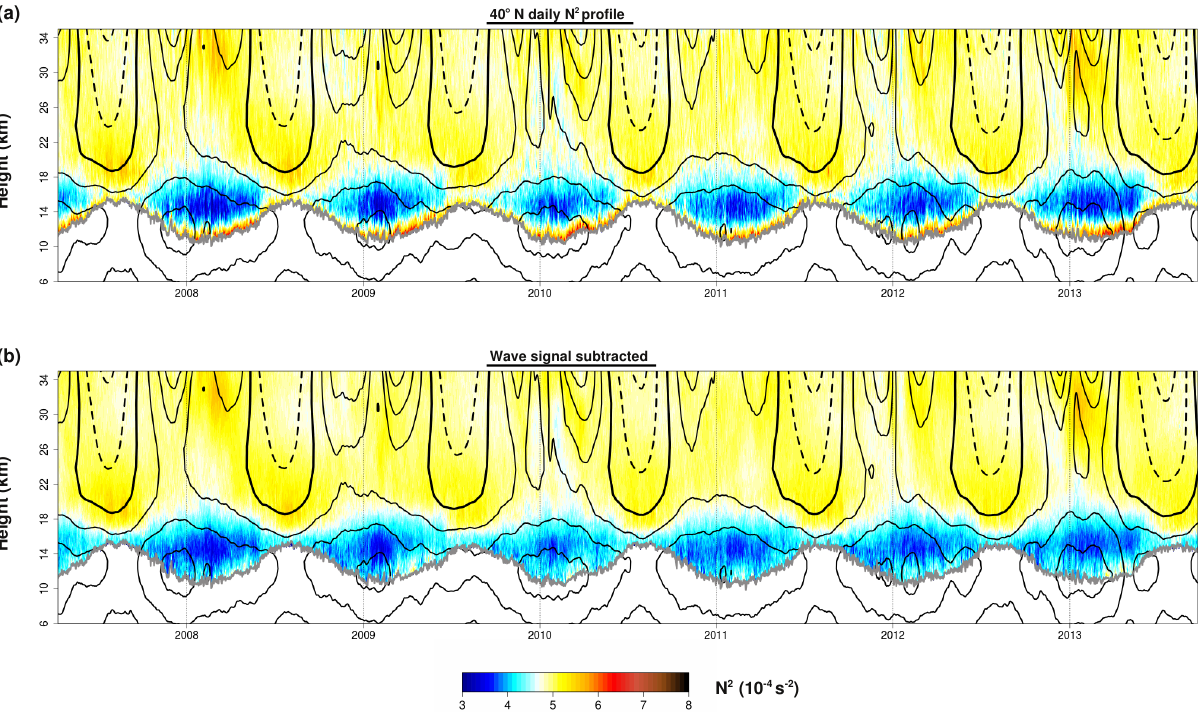
Figure 5. (a) Daily evolution of the tropopause-based, 40 ◦ N zonal mean N 2 vertical profile between 2007 and 2013 (colors) from COSMIC GPS-RO profiles. The grey line denotes the tropopause height (TP z ). Thin black contours denote positive (westerly) mean zonal wind, with a thicker contour for the zero line, dashed contours for negative (easterly) winds, and a 10ms − 1 separation. Winds were obtained from the ERA-Interim reanalysis. To improve visibility, the winds are displayed with a running mean of ± 15 days. No running mean is applied to the N 2 vertical profile or TP z in order to allow the subtraction of the extratropical wave signal. Note that tropospheric N 2 values are not included in the color scale and therefore left blank. (b) Same as in Fig. 5a, but the wave signal has been subtracted from the N 2 vertical